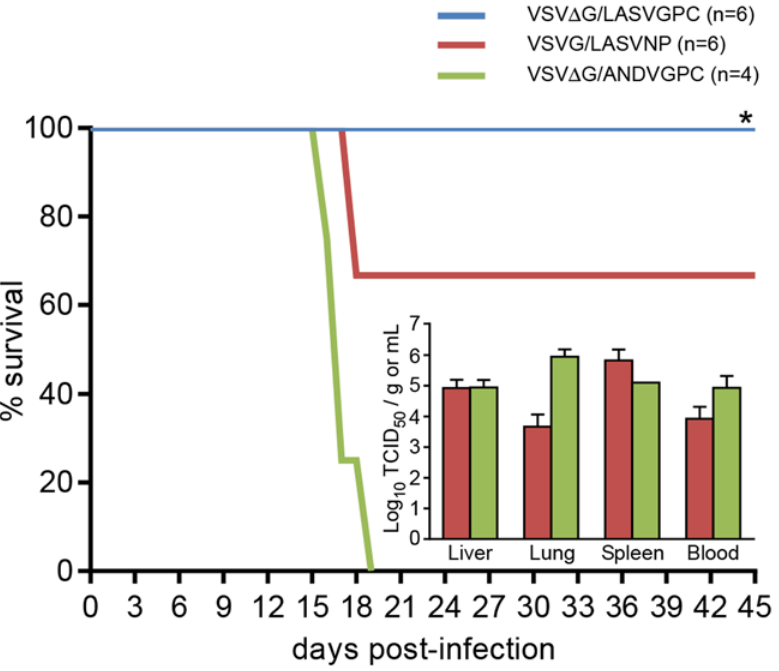
Fig 1. VSV Δ G/LASVGPC affords better protection than VSVG/LASVNP against a lethal homologous challenge in strain 13 guinea pigs. Adult, inbred strain 13 guinea pigs were immunized with 1 x10 6 pfu of VSV Δ G/LASVGPC (n = 9), VSVG/LASVNP (n = 9) or VSV Δ G/ANDVGPC (n = 4) and challenged 28 days later with a lethal dose of Lassa virus strain Josiah. Animals were monitored for disease progression for 45 days. At the time when control (VSV Δ G/ANDVGPC immunized) animals demonstrated signs of advanced disease requiring euthanasia, three animals per group were euthanized and samples collected for virological analysis (inset). * p =